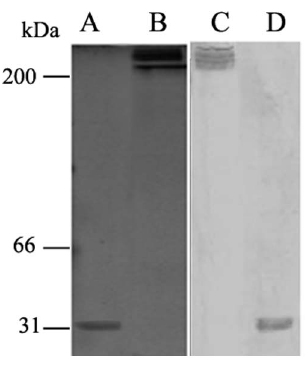
Figure 1. SDS-PAGE and WB analysis of the purified MBL protein. The purified proteins were separated on a 12.5% gel under reducing or non-reducing conditions: (A) SDS-PAGE analysis of the purified MBL under reducing conditions; (B) SDS-PAGE analysis of the purified MBL under non-reducing conditions; (C) WB analysis of the purified MBL under non-reducing conditions; (D) WB analysis of the purified MBL under reducing